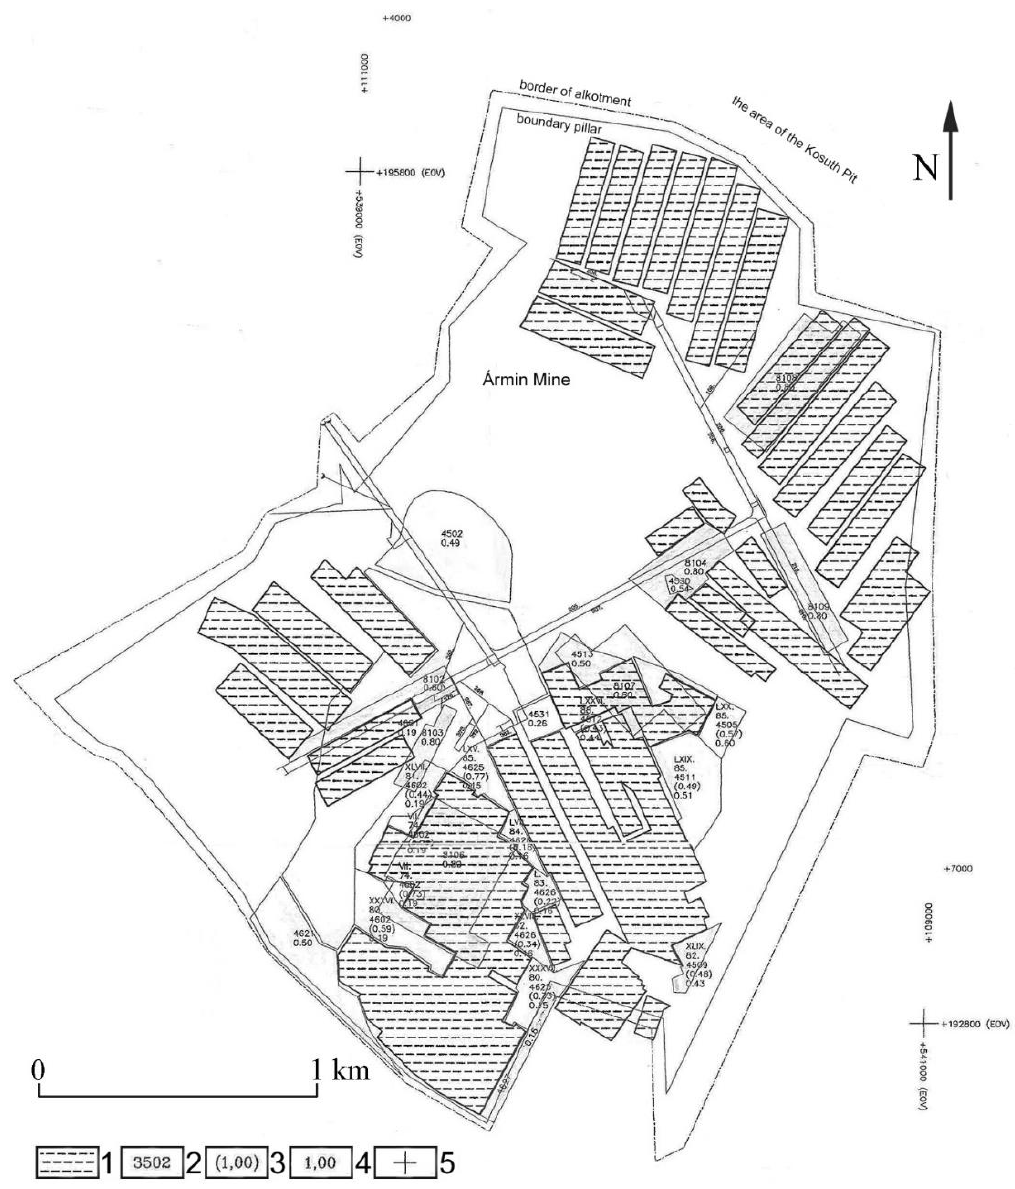
Figure 8. Map of bed IV of Á rmin mine [28]. Legend: 1. excavation, 2. block number, 3. abandoned mineral reserves, original mineable value 4. mineable value, 5. map coordinate.